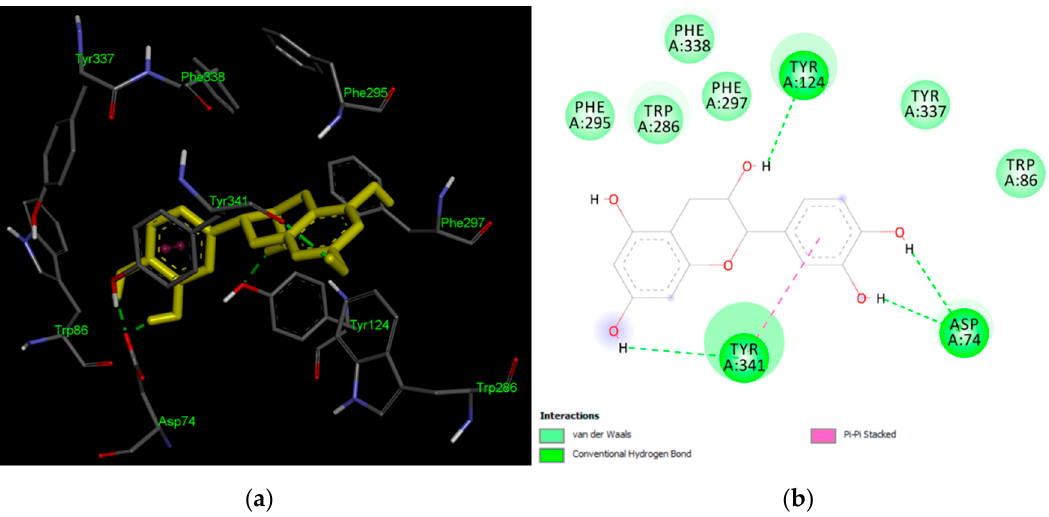
Figure 4. Active site of the AChE enzyme with epicatechin: ( a ) 3D view; ( b ) 2D view.